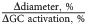
Arteriole sensitivity to NO increases the amplitude of the undershoot and vasomotion.All simulations for this figure used a dynamic model with a baseline diameter of 20 μm. A) Schematic of the variable RBC core model. Vasodilation increases the diameter of the RBC core and thus the degradation rate of NO in the variable RBC core model. B & C) Effective hemodynamic response function (B) and power spectrum (C) of the variable RBC core model from a white noise NO production rate. Note that with increasing NO sensitivity (slope, m Δdiameter,%ΔGCactivation,%), the magnitude of the undershoot and power near 0.2 Hz increases. D) Constant RBC core model where vasodilation does not increase the diameter of the RBC core and thus the degradation rate of NO does not change. E & F) No post-stimulus undershoot is present (E) and the maximum power of the constant RBC core model is at low frequencies (<0.1 Hz) (F). G) 60 second example taken from a 25 minute trial displaying NO production and resultant diameter changes from which arteriole dynamics were evaluated. H & I) Juxtaposition of variable (red) and constant (blue) RBC core models for m = 5 showing the post-stimulus constriction (H) and peak power between 0.1–0.3 Hz (I) in the variable RBC core case (red) while no undershoot or peak power between 0.1–0.3 Hz is present if the RBC is held constant during vasodilation (blue).